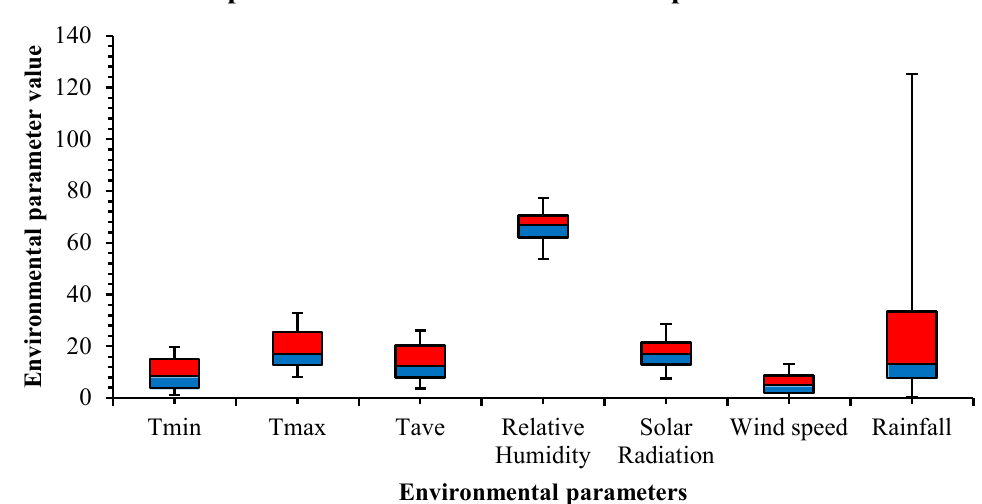
Figure A1. Box plot correlations of environmental parameters at Molise region over the study period from 1 January 2019 to 31 December 2021. (Note: Tmin, Tmax, and Tave = minimum, maximum, and average temperatures (°C); relative humidity at 9:00 to 21:00 (local time) (%); solar radiation (MJ m 2 month −1 ); wind speed (m s −1 ); and rainfall (mm)).